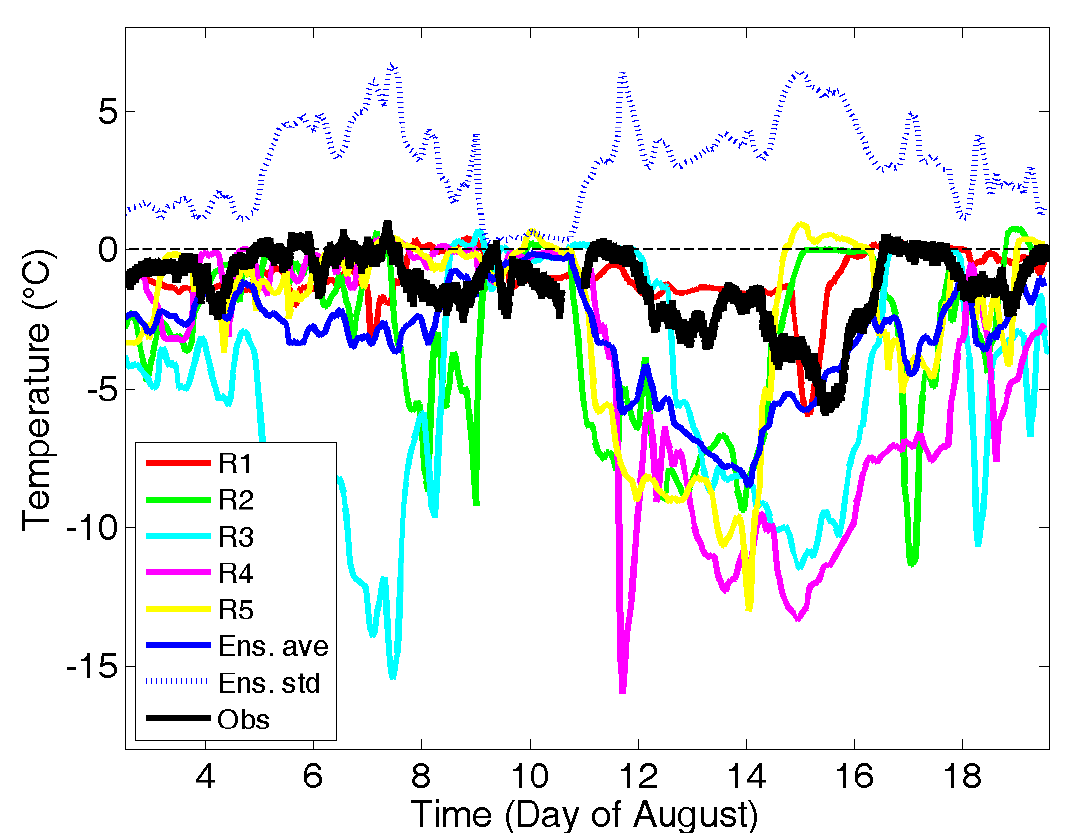
Figure 3. Near-surface temperature (°C), as a function of time, from observations on the ice during the ice drift and from the ensemble average and the different members. Also shown is the ensemble standard deviation. All the model output is instant hourly while the observations are 1-minute